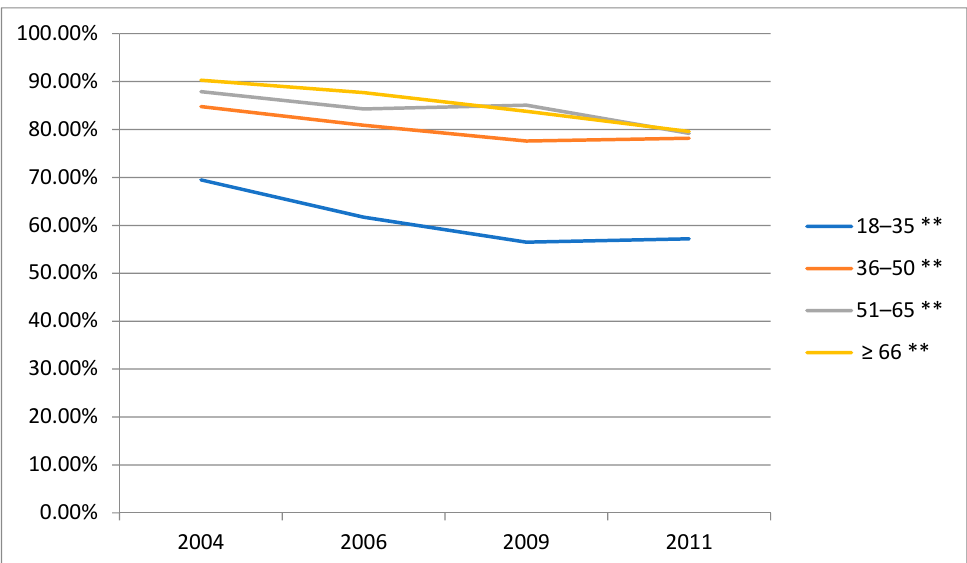
Figure 4. Time trends in the prevalence of alcohol consumption (liqueur) amongst male drinkers by age groups, CHNS. ** Statistically significant ( p < 0.01).